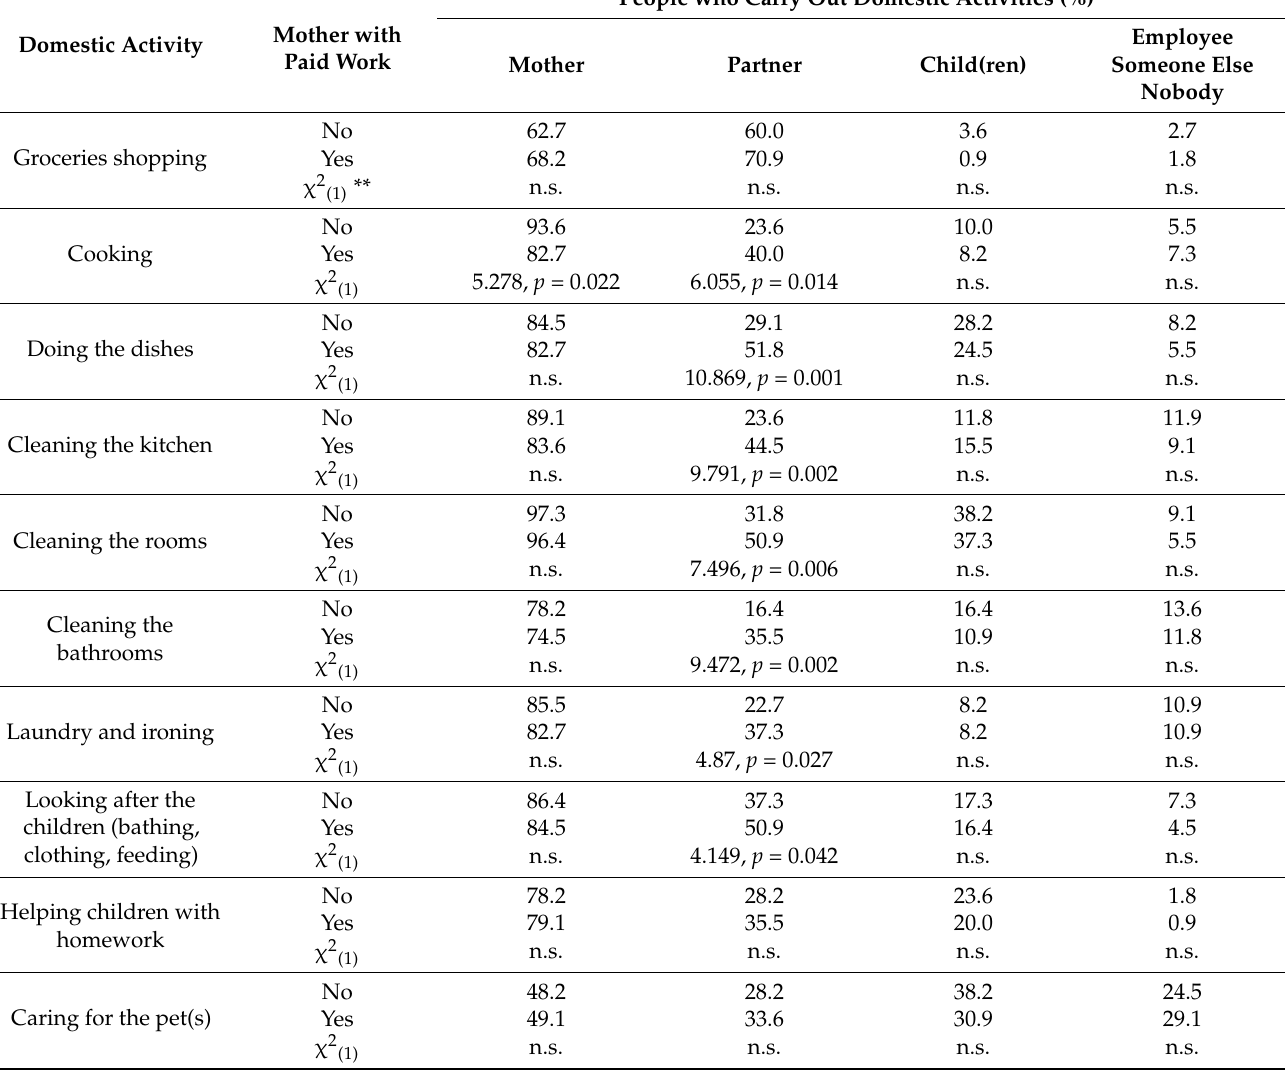
Table 2. People in the family who carry out domestic activities and differences between mothers with and without paid